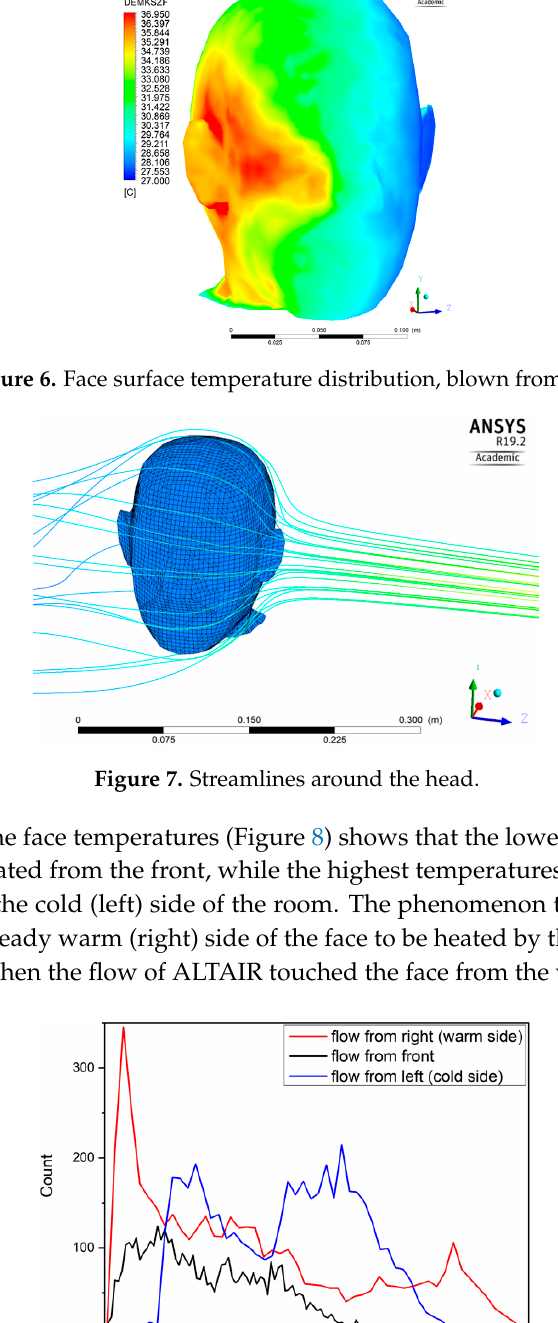
Figure 9. Sketch of the measurement setup.